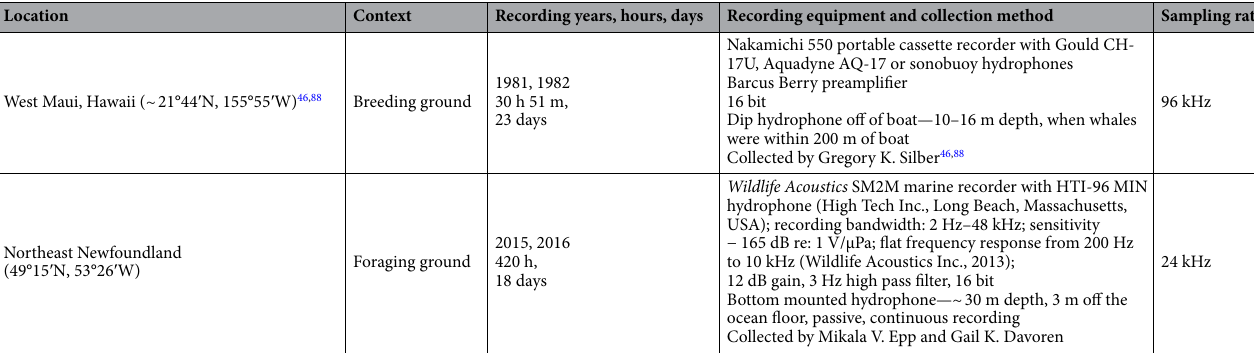
Table 1. Description of recording equipment, settings, and contexts for each study